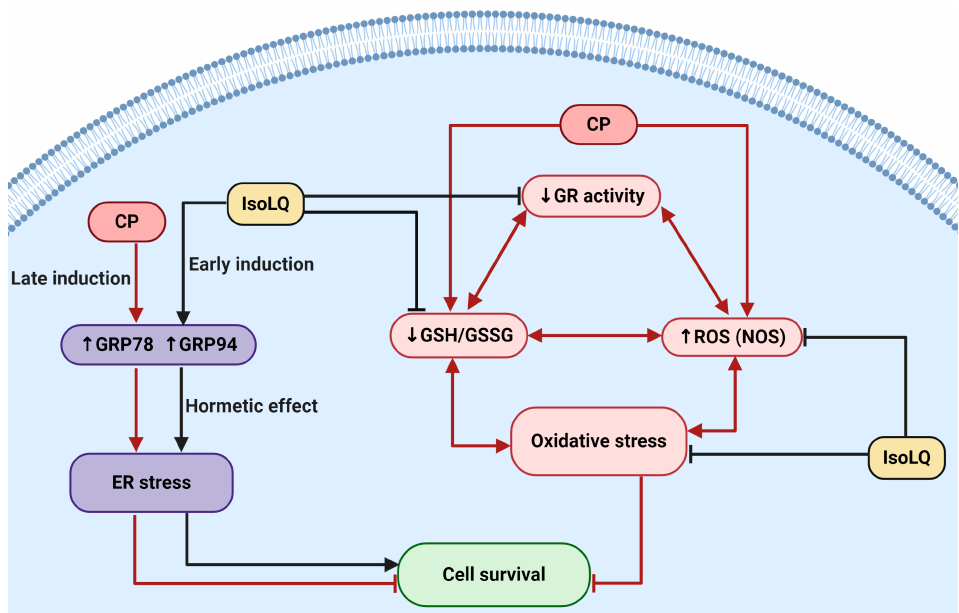
Figure 8. Mechanisms involved in the protective effect of isoliquiritigenin (IsoLQ) against cisplatin (CP)-induced damage in LLC-PK1 cells. Pretreatment with IsoLQ increased the expression of glucose-regulated protein 78 (GRP78) and glucose-regulated protein 94 (GRP94), markers of endoplasmic reticulum (ER)-stress. The generated hormetic effect induces a decrease in reactive oxygen species (ROS) production, associated to nitric oxide synthase (NOS) activity, as well as the attenuation in the reduction of glutathione/glutathione disulfide (GSH/GSSG) ratio and glutathione reductase (GR) activity. These combined effects, in addition to the antioxidant properties of IsoLQ, attenuated oxidative stress. Figure was created with Biorender. com.